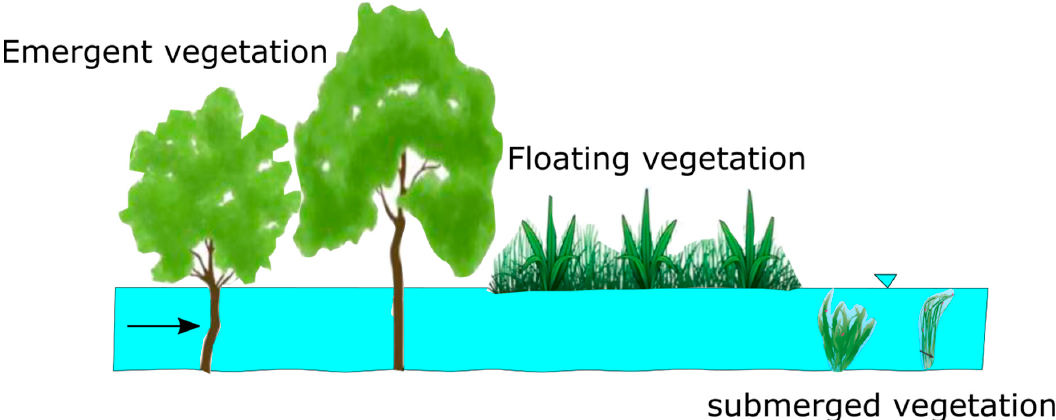
Figure 1. Different types of vegetation in open channel flow.